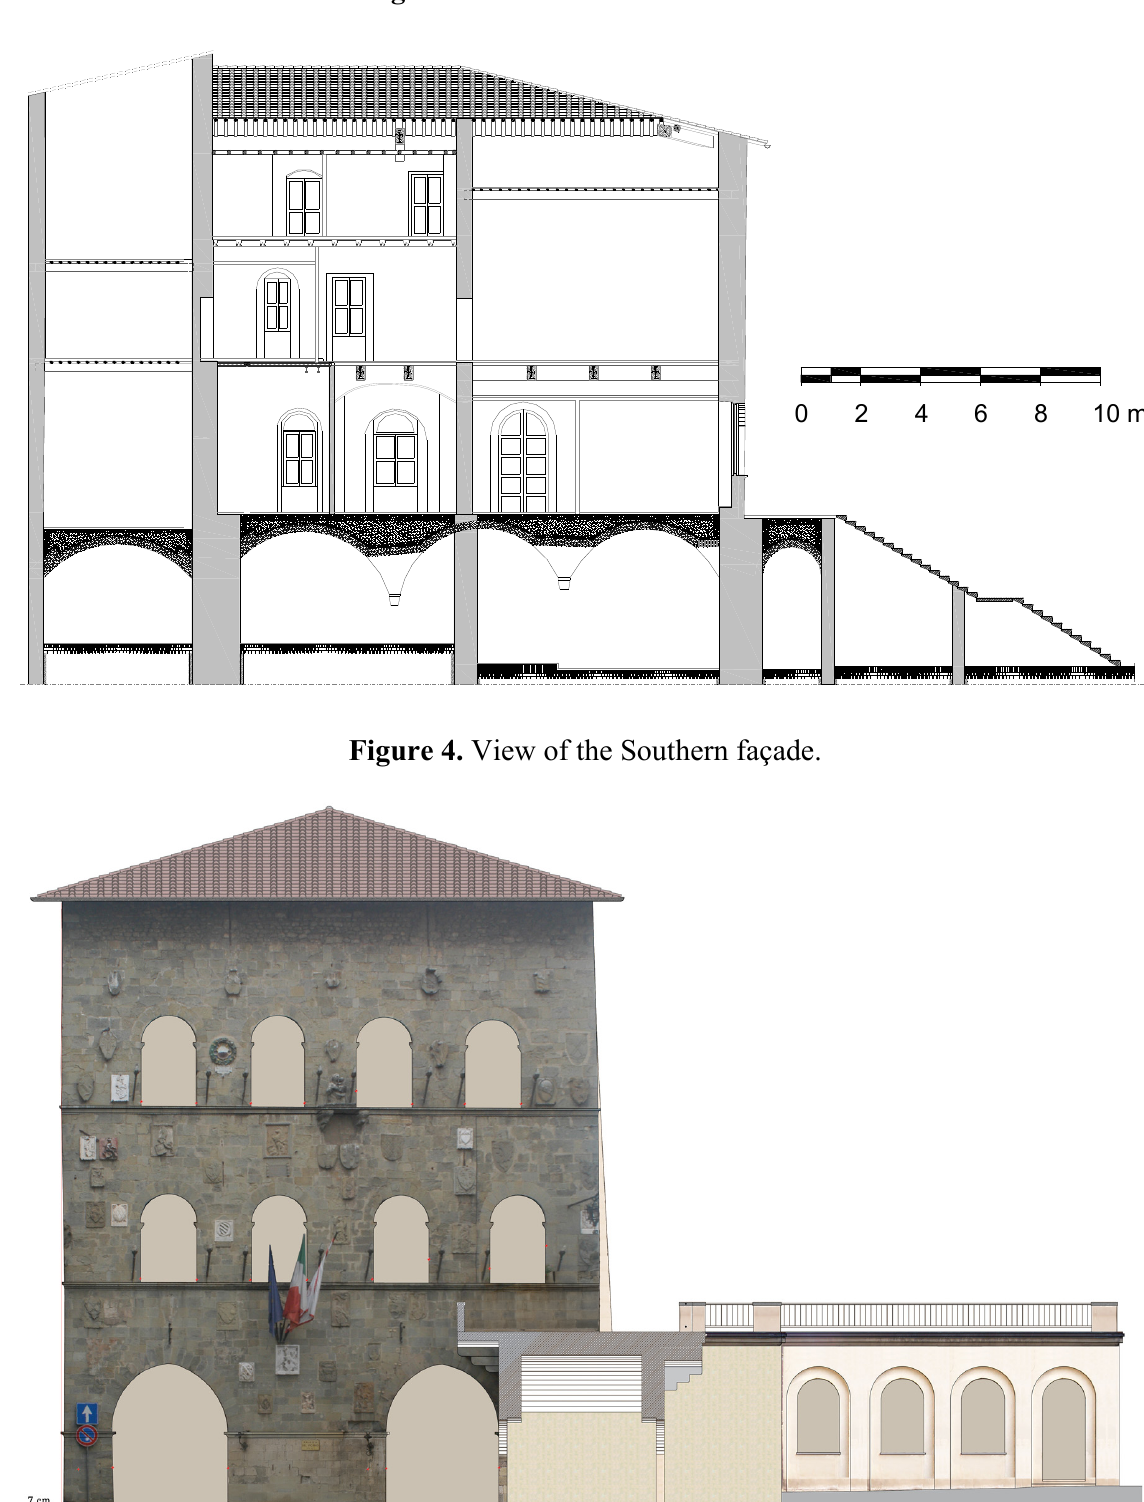
Figure 3. Section A-A of the Palace.